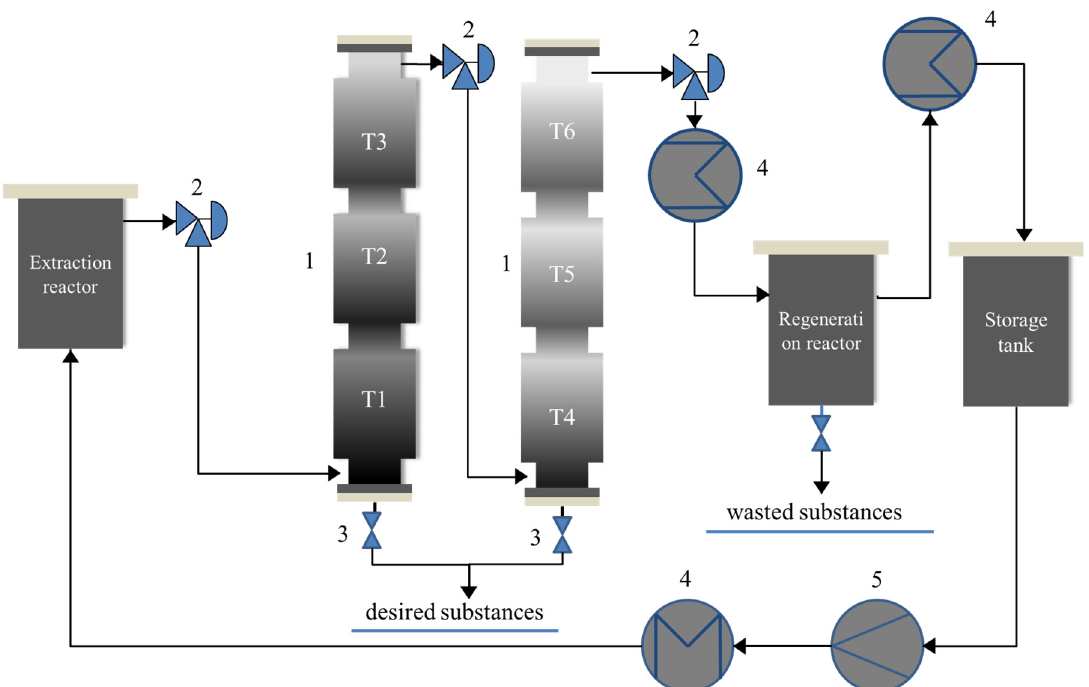
Figure 4. The schematic diagram of supercritical fluid extraction (1—segmented desorption reactor; 2—high-pressure valve; 3—normal valve; 4—heat exchanger; 5—high-pressure pump).